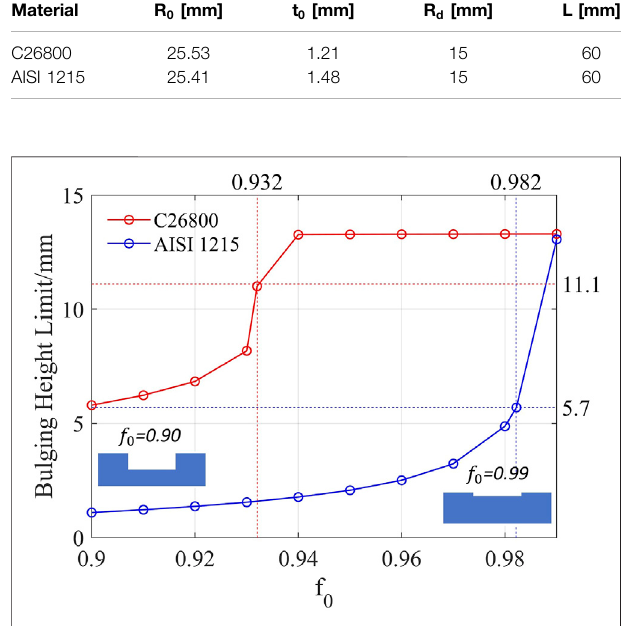
FIGURE 7 | Effect of the initial imperfection factor f 0 on the